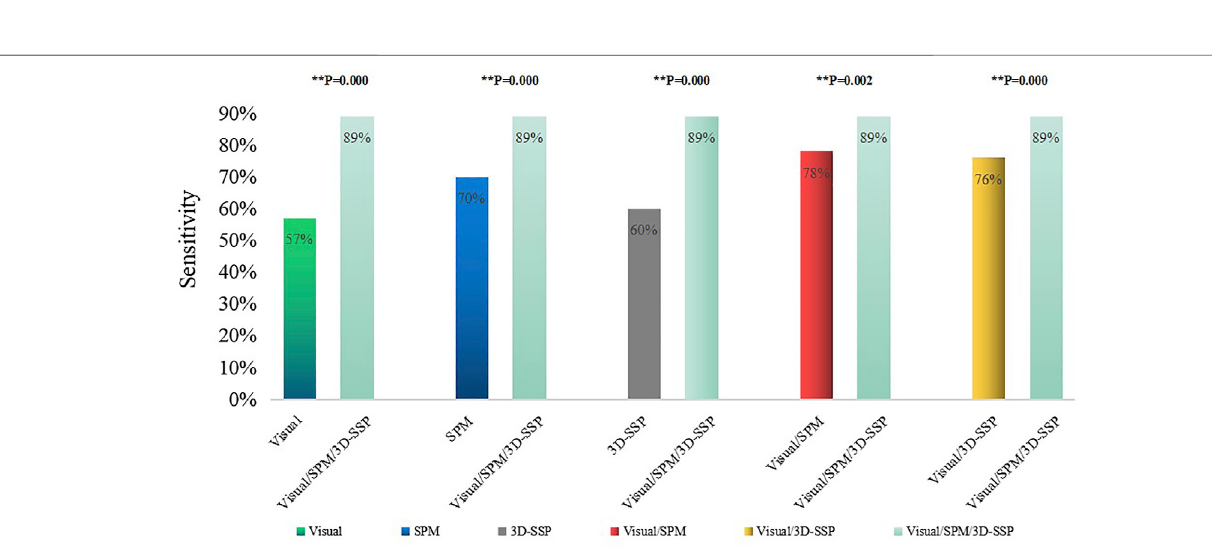
Frontiers in Bioengineering and Biotechnology |